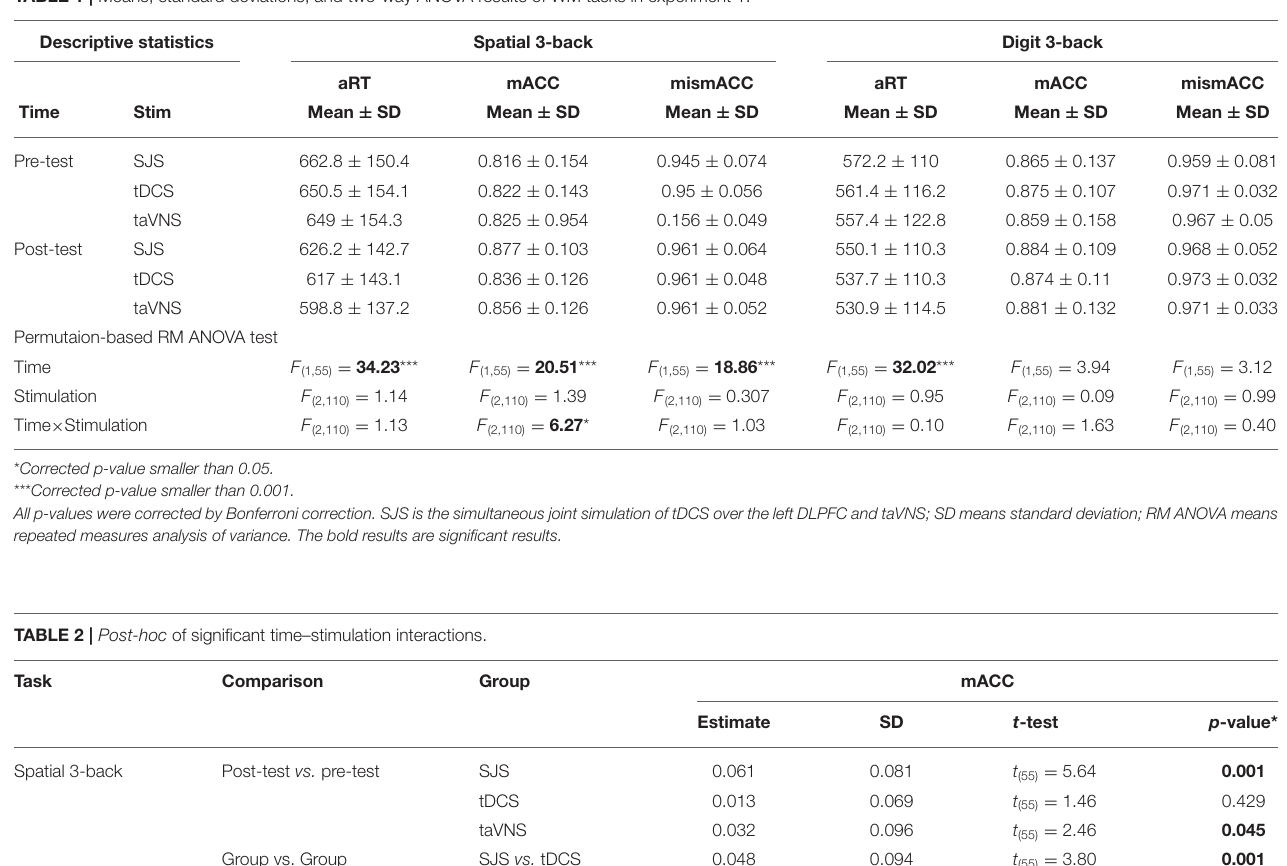
( Table 1 ). Direct comparison of stimulation conditions using accuracy 1 -scores revealed significant group differences between significant difference between SJS-L and taVNS was